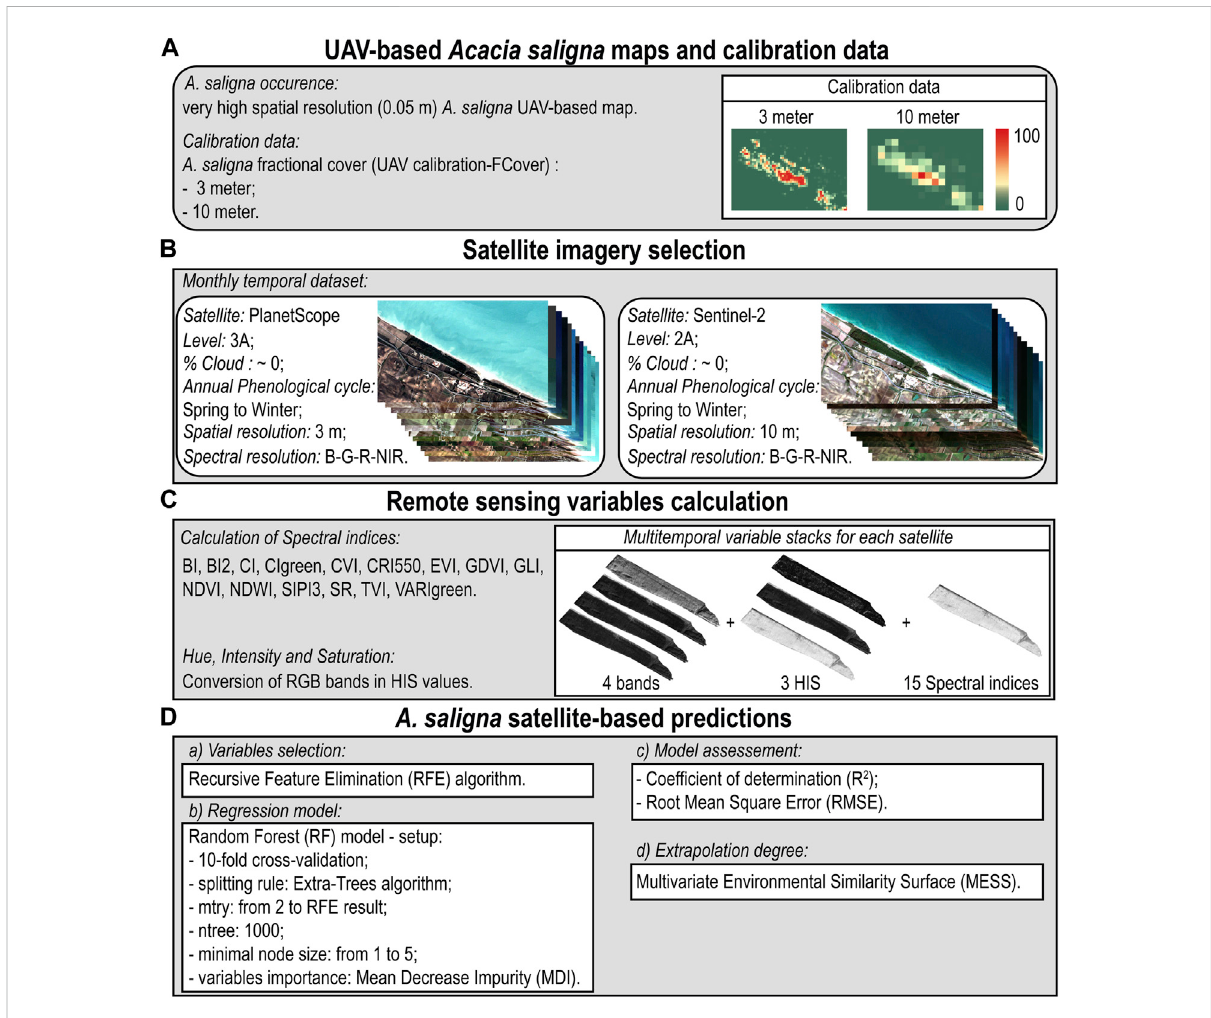
FIGURE 2 Work fl ow synthesizing the procedure for the satellite-based prediction of A. saligna distribution using the UAV-based IAS VHR information as calibration data. The proposal framework: (A) UAV-based A. saligna maps and calibration data, (B) Satellite imagery selection, (C) Remote sensing variables calculation, (D) A. saligna satellite-based